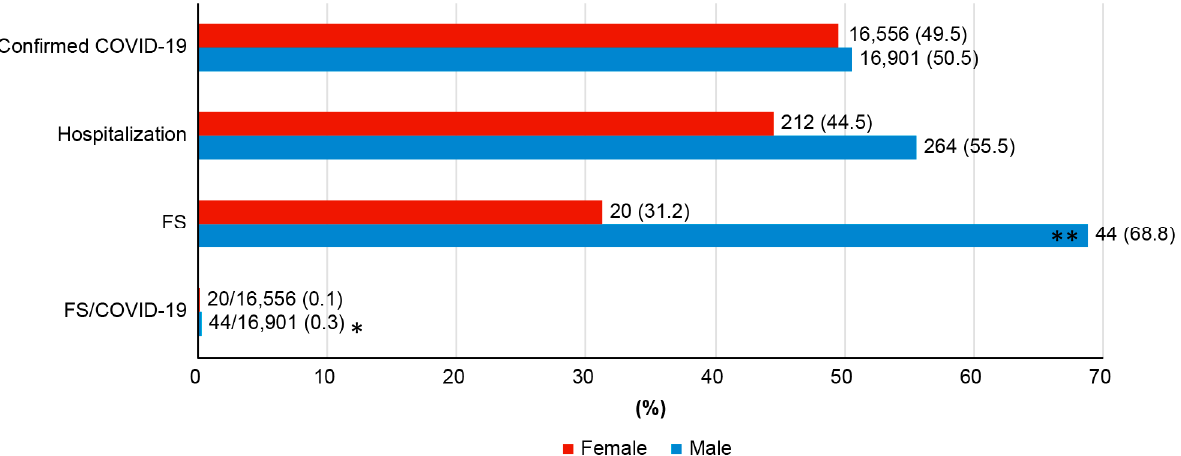
COVID-19; coronavirus 2019, FS; Febrile seizure. The * indicates the ratio of hospitalized patients with COVID-19 to confirmed COVID-19 patients. The ** indicates the ratio of febrile seizure patients with COVID-19 to confirmed COVID-19 patients. Figure 1. Confirmed COVID-19 cases, hospitalization rates, and febrile seizures according to sex.